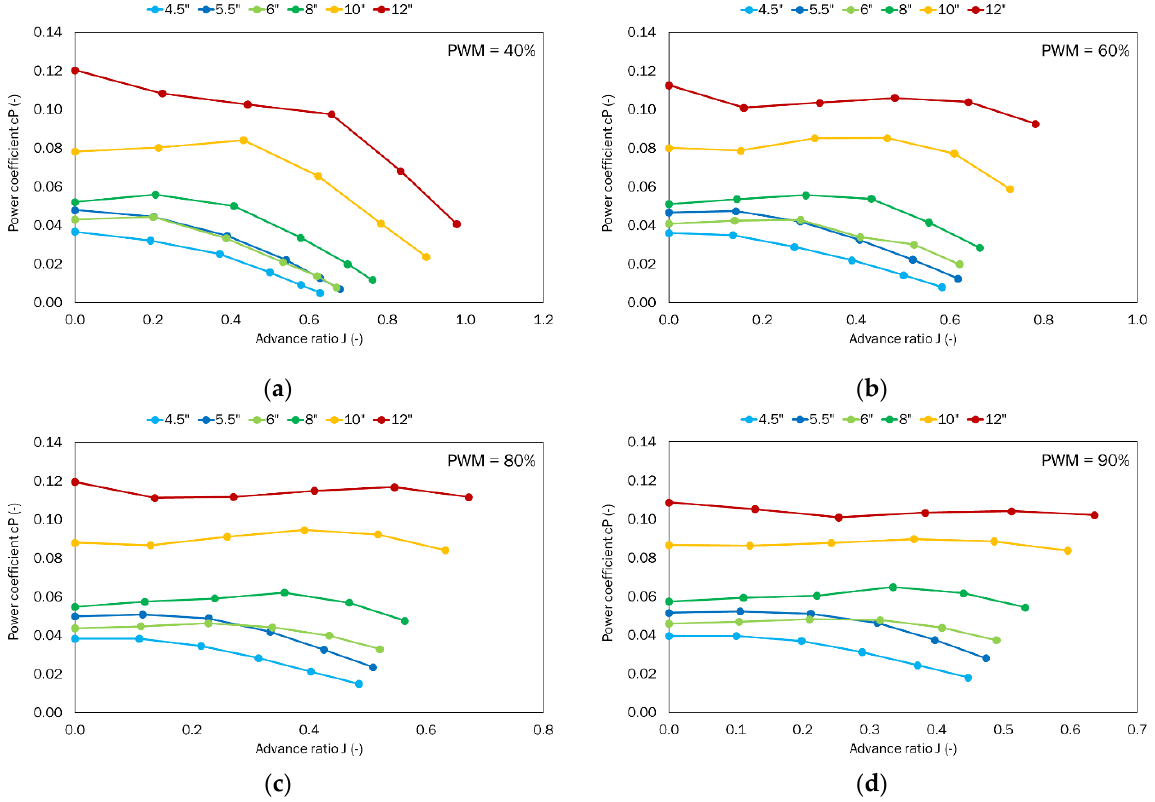
Figure 11. Power coefficient as a function of the advance ratio for the tested set of propellers for the defined PWM values: ( a ) 40%; ( b ) 60%; ( c ) 80%; ( d ) 90%. defined PWM values: ( a ) 40%; ( b ) 60%; ( c ) 80%; ( d )